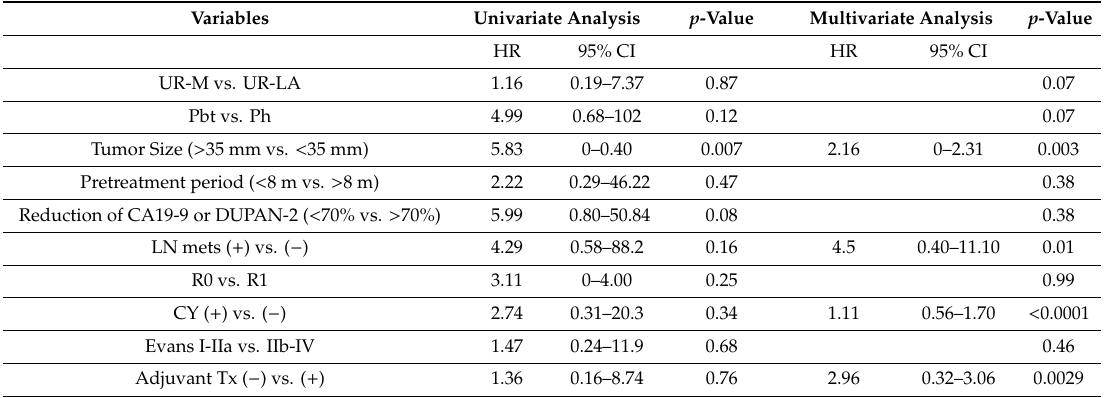
Table 3. Predictive factor for the recurrence within six months after CS (Univariate and multivariate logistic regression